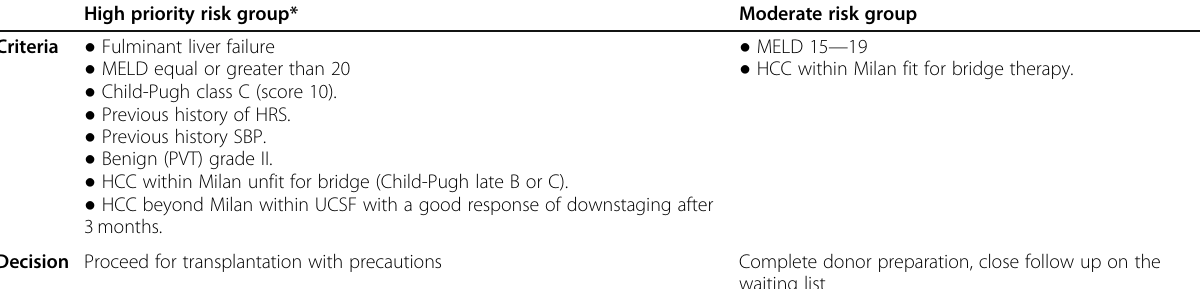
Table 1 Recipient selection for LDLT during SARS-CoV-2 pandemic High priority risk group*